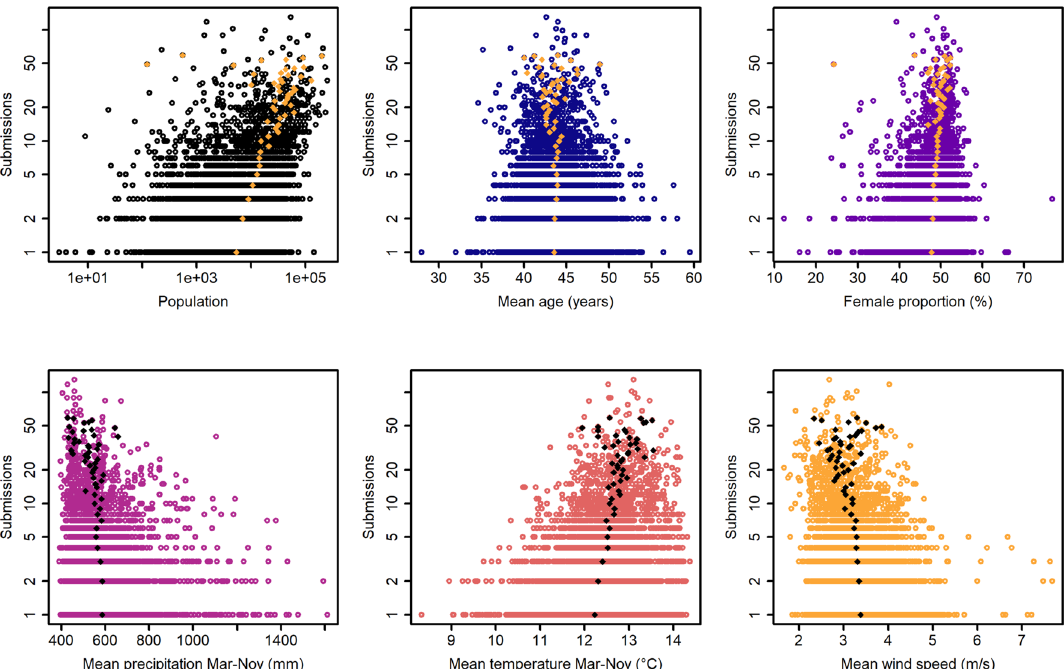
Figure 5. Scatterplots of the six non-factor predictors plotted against the number of submissions on a log- transformed y-axis. In the case of ‘population’, both axes are log-transformed. The yellow and black diamonds indicate average values per submission